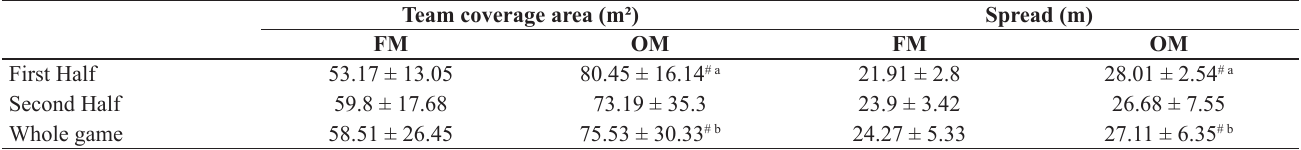
Table 3. Values of organization on the court variables during the official match (OM) and pre-season friendly match (FM). Results are presented in mean ± standard deviation.